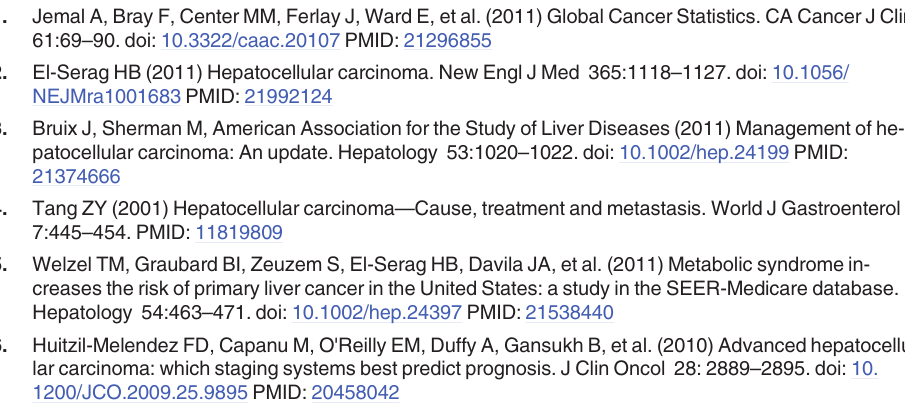
S1 Table. Baseline characteristics of 181 samples from